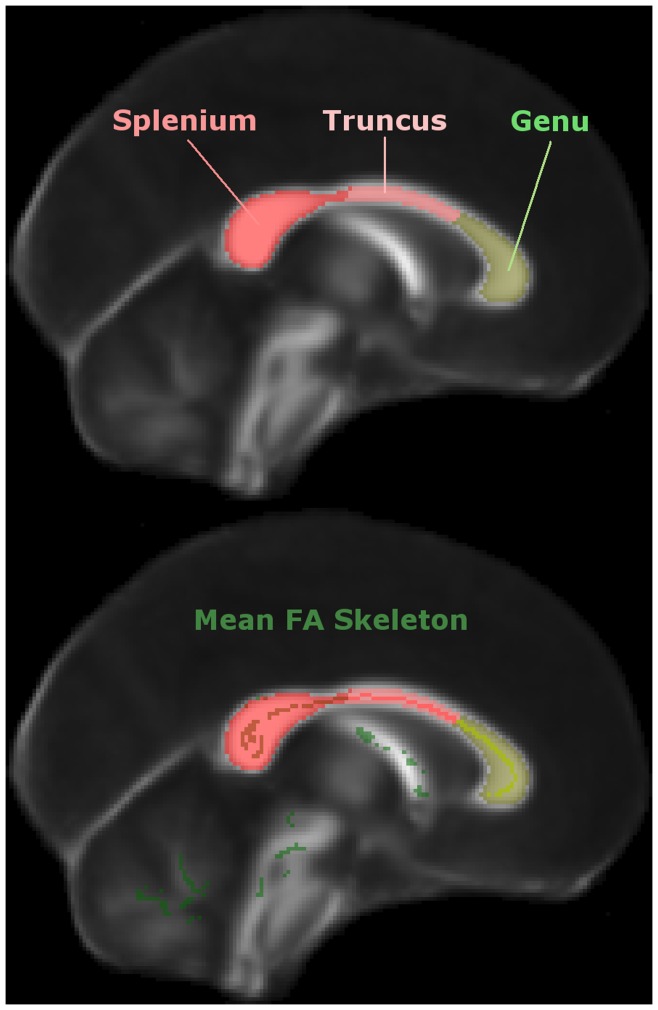
Corpus callosum subdivision.Depiction of the semi-automated callosal subdivision into splenium, truncus and genu (top), and their intersection with the mean FA skeleton inferred from N = 69 subjects–N = 43 Alzheimer’s disease patients and N = 26 matched controls (bottom).